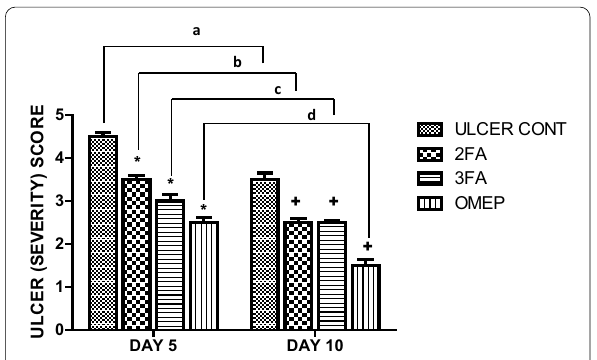
Fig. 8 Effect of folic acid (2 mg/kg), folic acid (3 mg/kg), and Omeprazole on acetic acid induced gastric ulcer: ulcer (severity) score ( p < 0.05 cf. ulcer control, day 5; ∗ 10; a–d p < 0.05 cf. each group on day 10. ULCER CONT